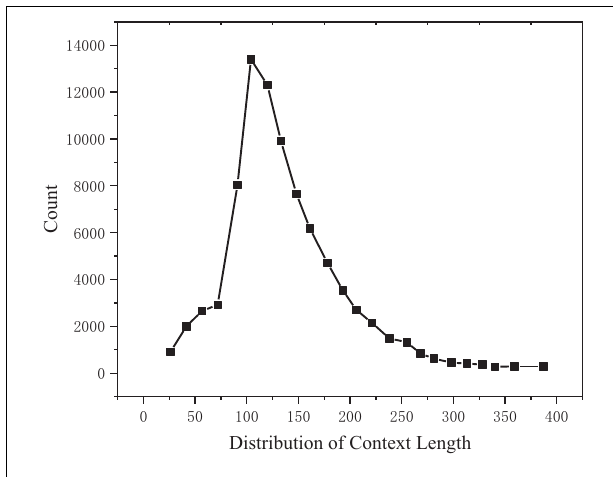
FIGURE 4 | Text length distribution.